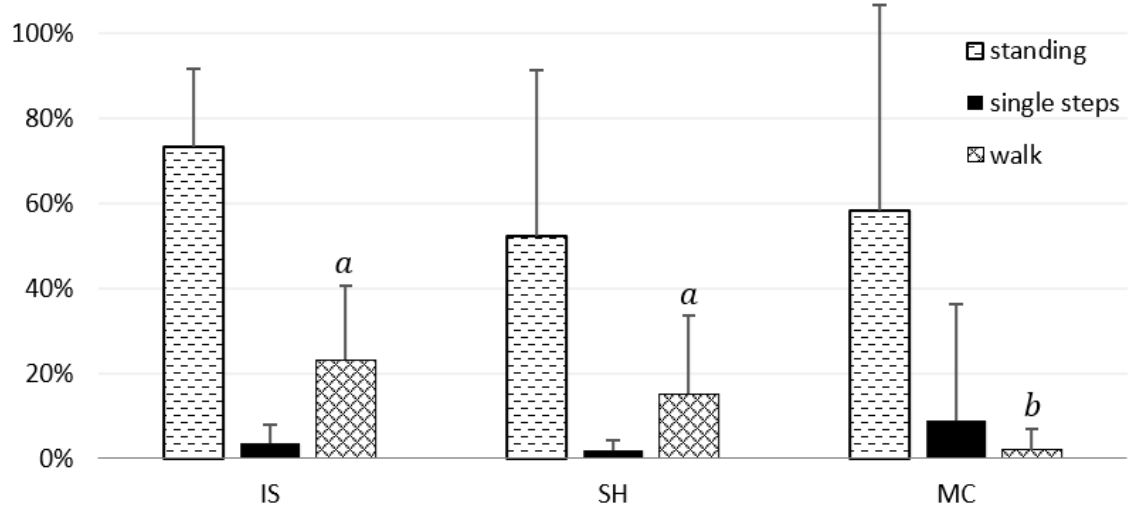
Figure 2. Percentages of time of standing, single steps, and walk with regard to the paddock conditions: IS—insolated, SH—shaded, MC—under mist curtain. Vertical lines show the standard deviation. Means marked with different letters within a kind of locomotor behaviour significantly differ at p < 0.05; the same letters or lack of letters indicate that significant differences do not appear.